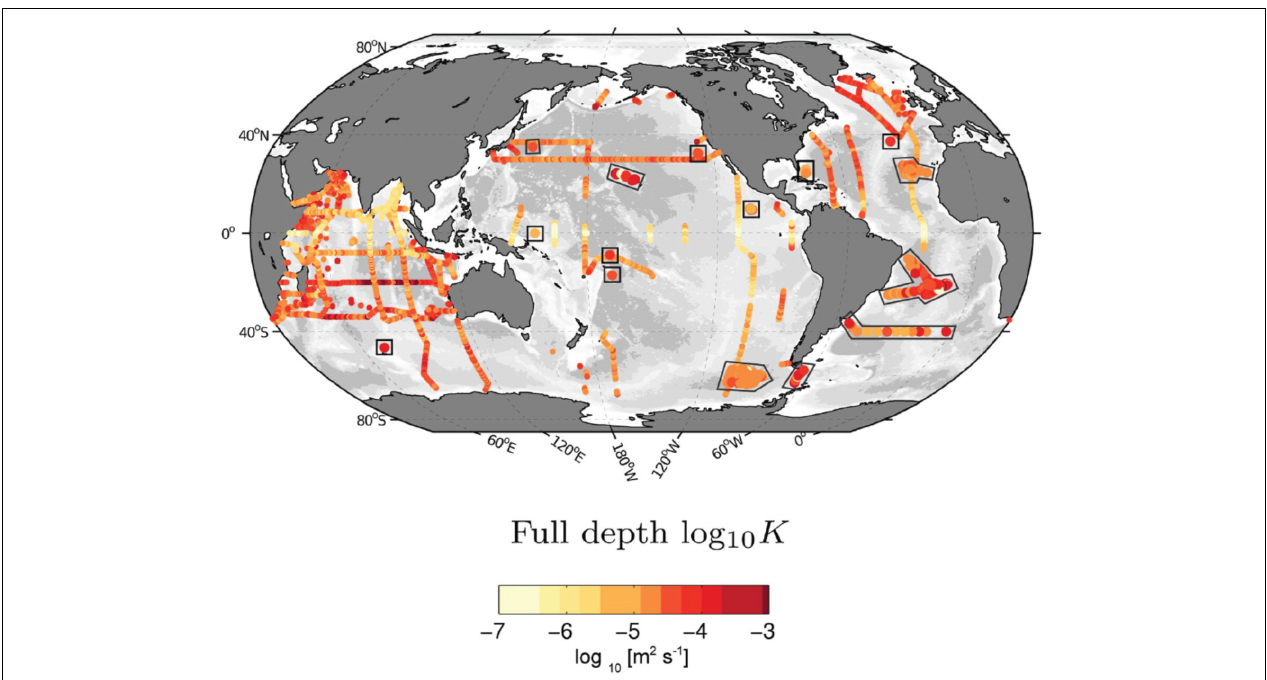
FIGURE 4 | Depth-averaged diffusivity from the surface to the bottom from all existing full-depth microstructure observations as of Waterhouse et al. (2014). [Source: Waterhouse et al., 2014, Copyright 2014 American Meteorological Society (AMS). Reprinted with permission].